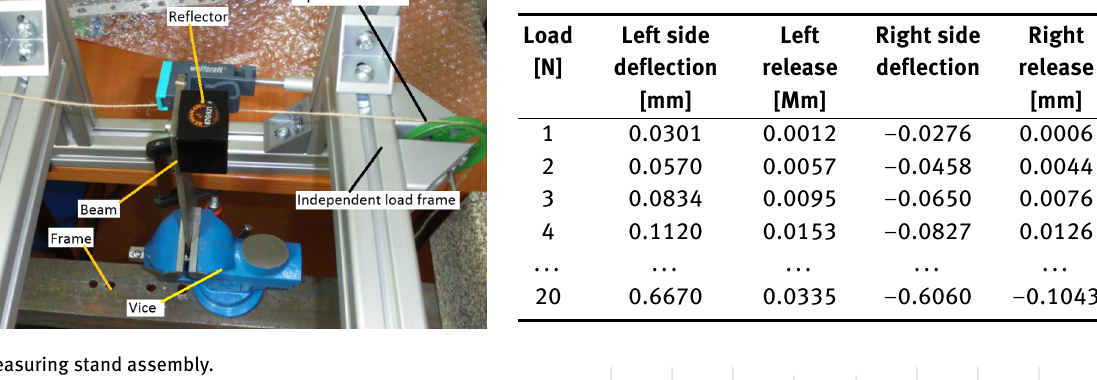
Table 1: First measurement record.